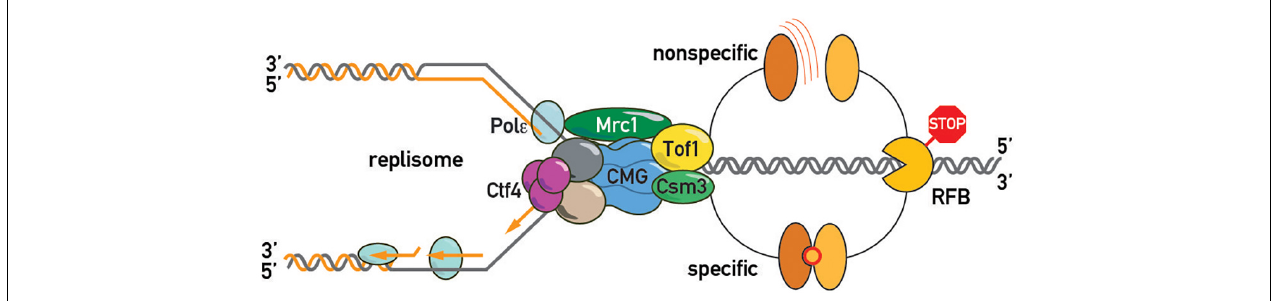
FIGURE 6 | Barrier recognition modes. The replisome recognizes barriers either non-specifically (top of the schematic; by clashing with a roadblock, e.g., tightly bound protein, or an altered DNA topology, e.g., supercoiled DNA, as shown in Figure 4 ) or through specific protein-protein interactions between barrier and replisome proteins (bottom of the